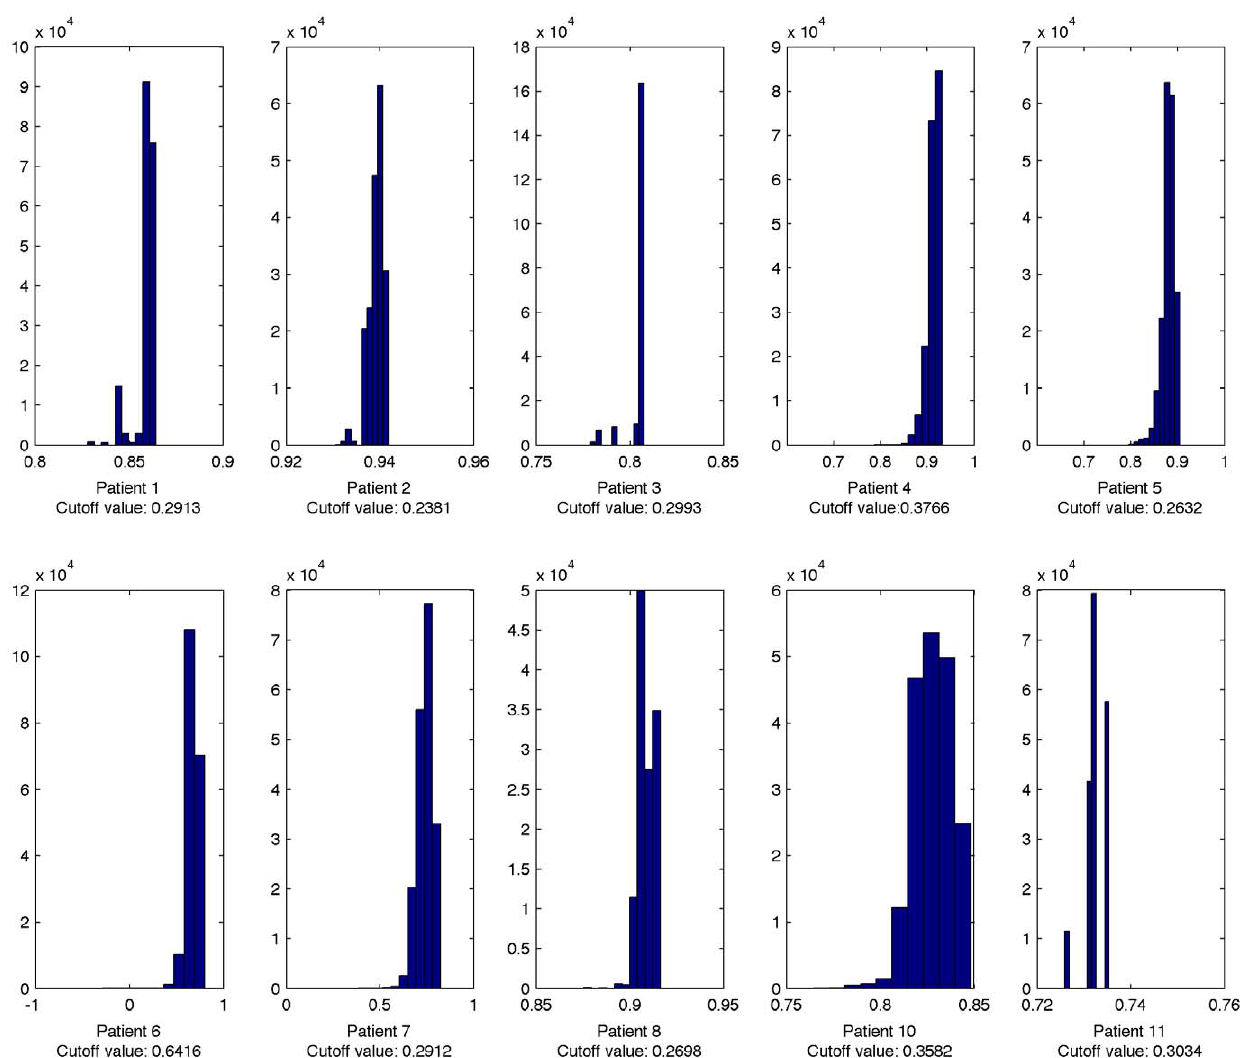
Figure 5. The histogram of coefficient of determination. R 2 Cutoff values: The value of R 2 corresponding to P =0.05.